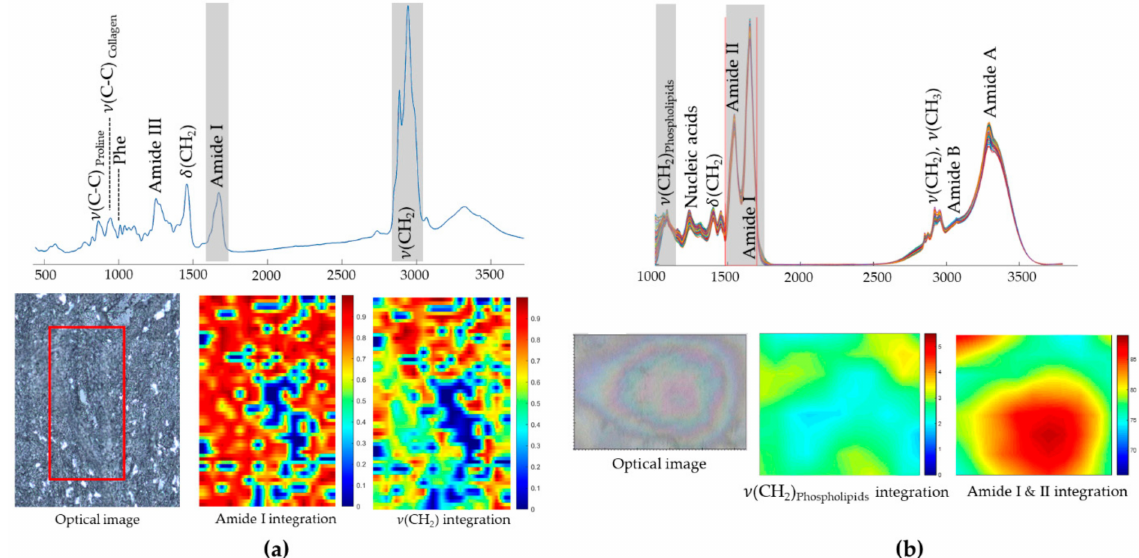
Figure 1. Typical spectra and biochemical images obtained by Raman and infrared microspectroscopy of biological samples: ( a ) Raman microspectroscopy of a human breast tissue section (Material not intended for publication: Mamede, A. P., Santos, I. P., Batista de Carvalho, L. A. E., QFM-UC, Coimbra, Portugal. Biochemical image of amide I and CH 2 stretching distribution in a human breast section, 2021); ( b ) infrared microspectroscopy (with synchrotron radiation) of a human osteosarcoma cancer cell (MG-63)